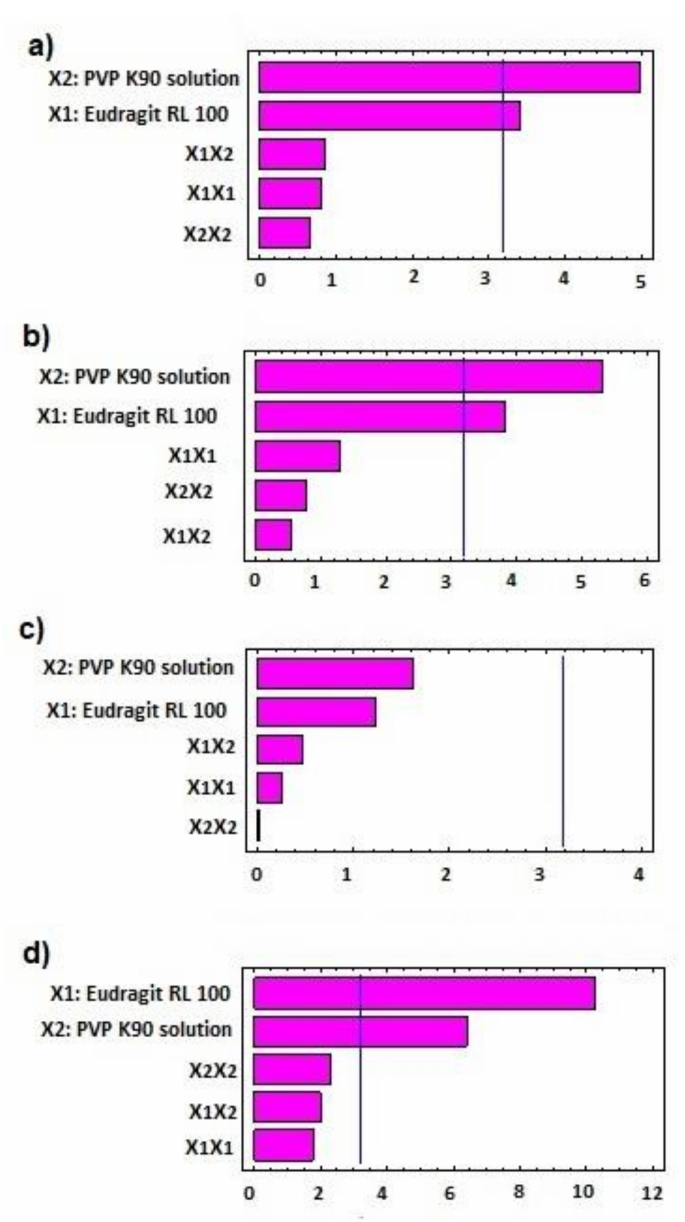
Figure 1. Standardized Pareto chart for ( a ) mean line torque, ( b ) pellet size, ( c ) release after 2 h, and ( d ) release after 8 h of AC sustained-release matrix